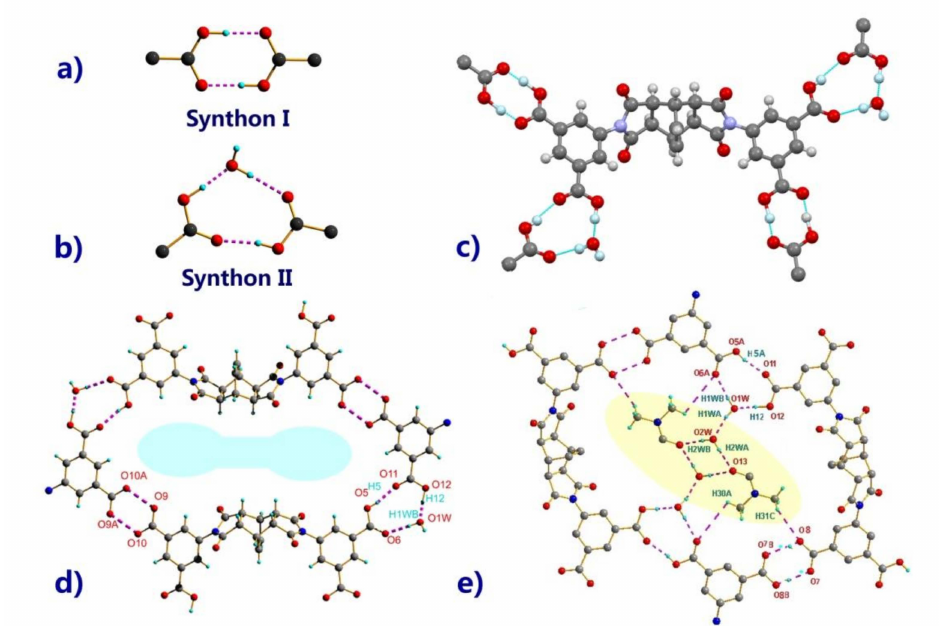
Figure 1. The homosynthon and heterosynthon ( a , b ); the H-bonds environment of one H 4 PTTA ( c ); two types of apertures: void ( d ) and fulfilled by lattice H 2 O and DMF ( e ) in 1-L